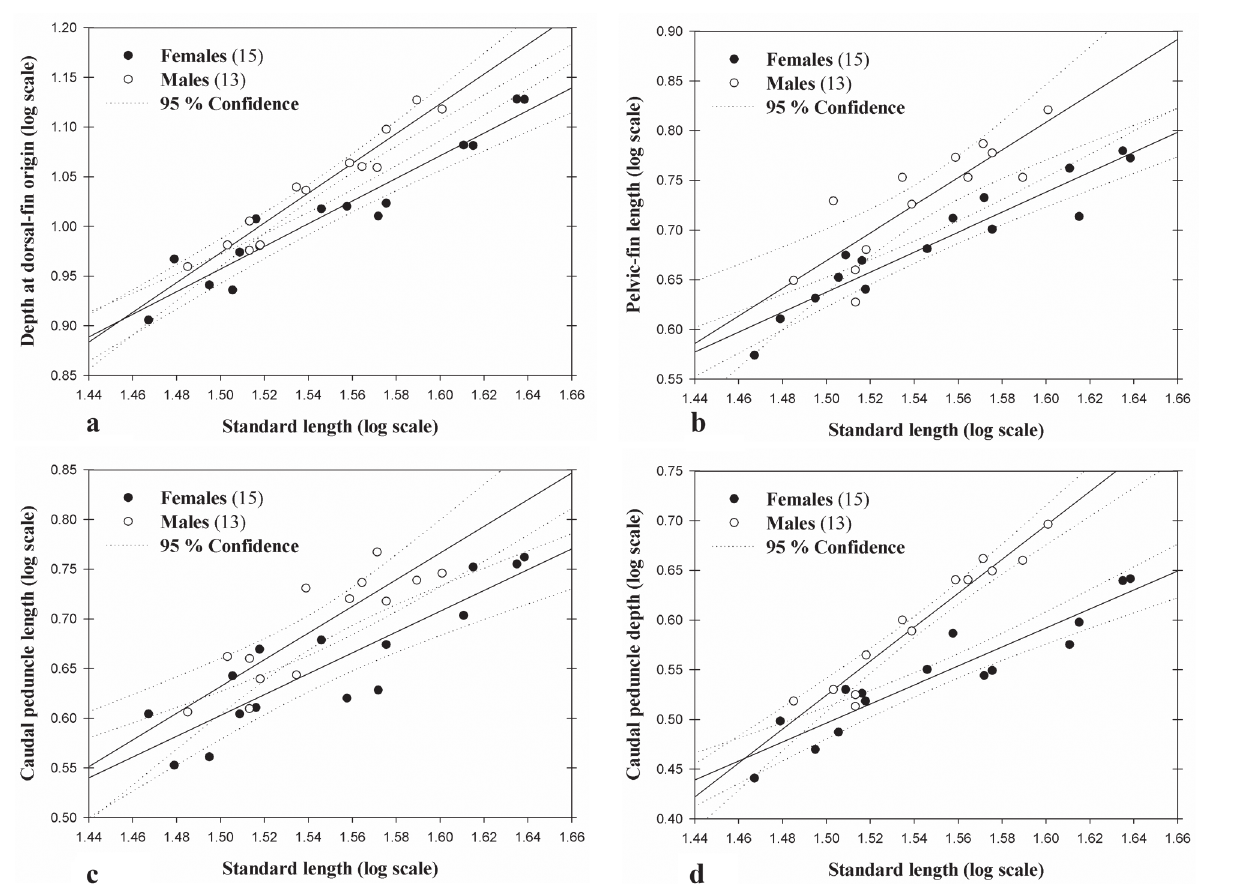
Fig. 7. Comparative regression plots of males and females of Chrysobrycon eliasi . ( a ) Depth at dorsal-fin origin as function of SL (females: r 2 = 0.92; males: r 2 = 0.94), ( b ) pelvic-fin length as function of SL (females: r 2 = 0.90; males: r 2 = 0.72), ( c ) caudal peduncle length as function of SL (females: r 2 = 0.79; males: r 2 = 0.76), ( d ) caudal peduncle depth as function of SL (females: r 2 = 0.87; males: r 2 =